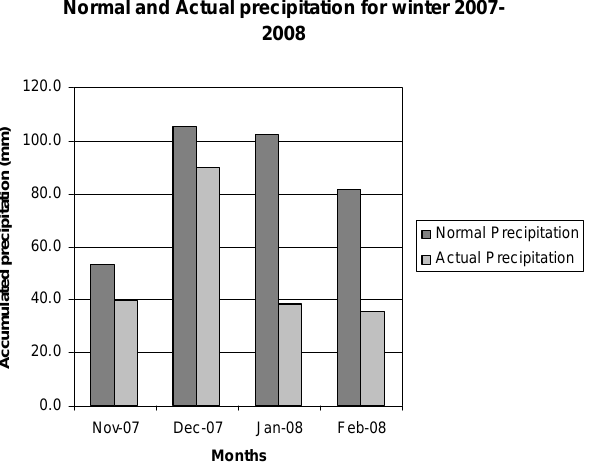
Fig. 1. Monthly total precipitation for November 2007 to Febru- Fig. 1 . Monthly total precipitation for November ary 2008, compared to the respective monthly normal